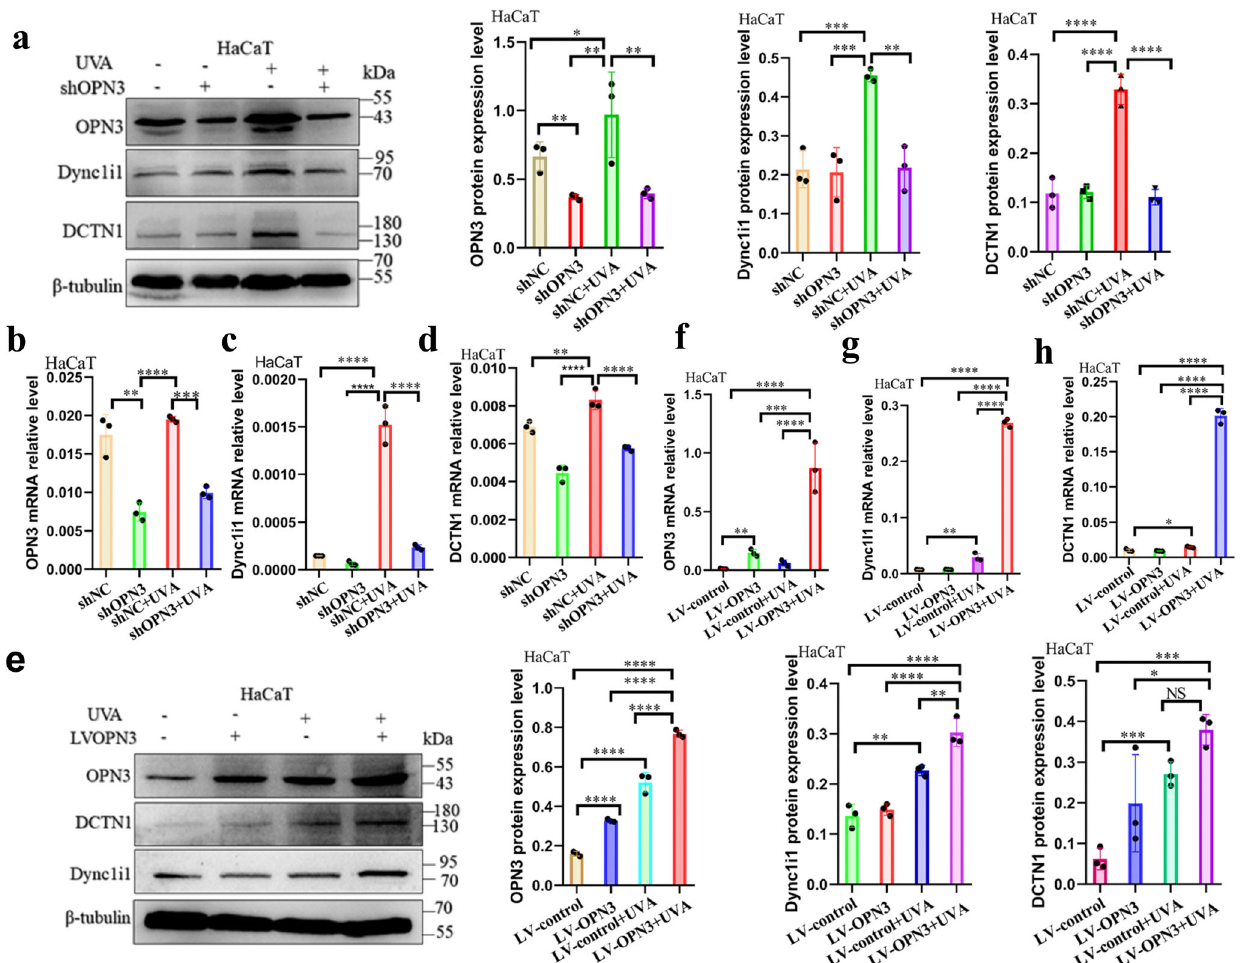
Fig. 4 UVA upregulates the expression of Dync1i1 and DCTN1 via OPN3. a HaCaT was transfected with lentivirus shOPN3 (shOPN3#1) and control lentivirus (shNC), and after irradiated without or with UVA, WB was used to analyze changes of OPN3, Dync1i1, and DCTN1 protein expression levels in HaCaT ( n = 3 independent experiments). WB analyses were normalized using β -tubulin as a loading control, and the relative protein level was quanti fi ed using Quantity One software. Statistical signi fi cance was determined by one-ANOVA with post-test. * P < 0.05, ** P < 0.01, *** P < 0.001, **** P < 0.0001. b – d After shOPN3 inhibited OPN3 irradiated without or with UVA, RT-qPCR was used to analyze changes of OPN3, Dync1i1, and DCTN1 mRNA expression in HaCaT ( n = 3 independent experiments). Statistical signi fi cance was determined by one-ANOVA with post-test. ** P < 0.01, *** P < 0.001, **** P < 0.0001. e HaCaT was transfected with lentivirus overexpression OPN3 (LV-OPN3) and control lentivirus (LV-control) and irradiated without or with UVA. Then, WB was used to analyze changes in OPN3, Dync1i1, and DCTN1 expression in HaCaT. β -tubulin was used as a loading control. Statistical signi fi cance was determined by one-ANOVA with post-test. * P < 0.05, ** P < 0.01, *** P < 0.001, **** P < 0.0001. f – h After LV-OPN3 overexpression of OPN3 irradiated without or with UVA, RT-qPCR was used to analyze changes in OPN3, Dync1i1, and DCTN1 expression levels in HaCaT. OPN3, Dync1i1, and DCTN1 mRNA levels were normalized to GAPDH levels ( n = 3 independent experiments). Statistical signi fi cance was determined by one-ANOVA with